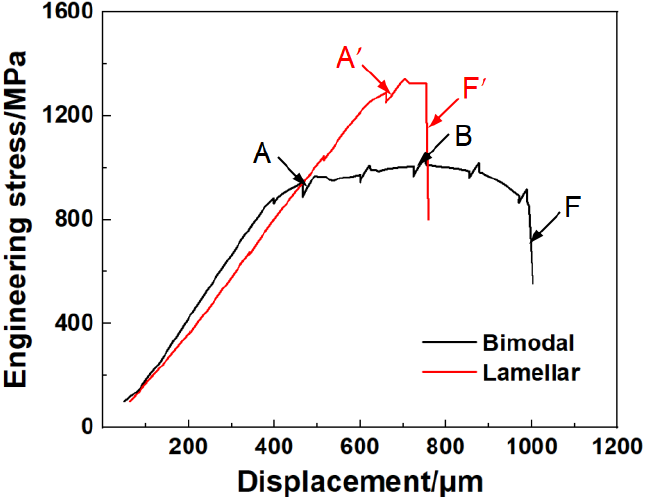
Figure 4. The stress–displacement curve of sample stretching in situ with bimodal and lamellar mi- crostructure at 350 °C.